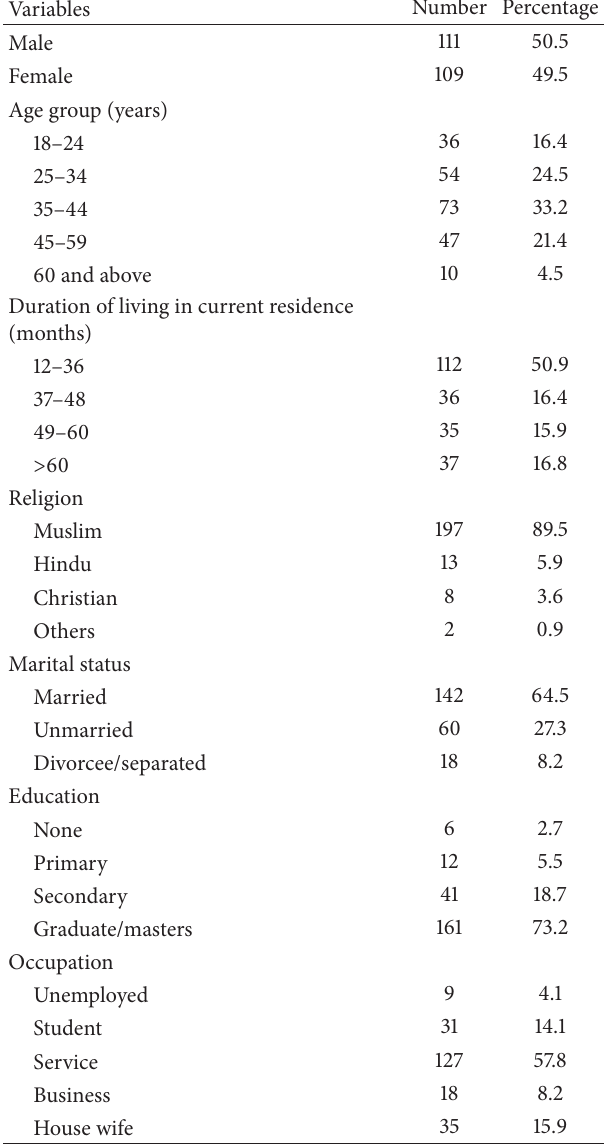
Table 1: Sociodemographic characteristics of the respondents (𝑛 = 220)